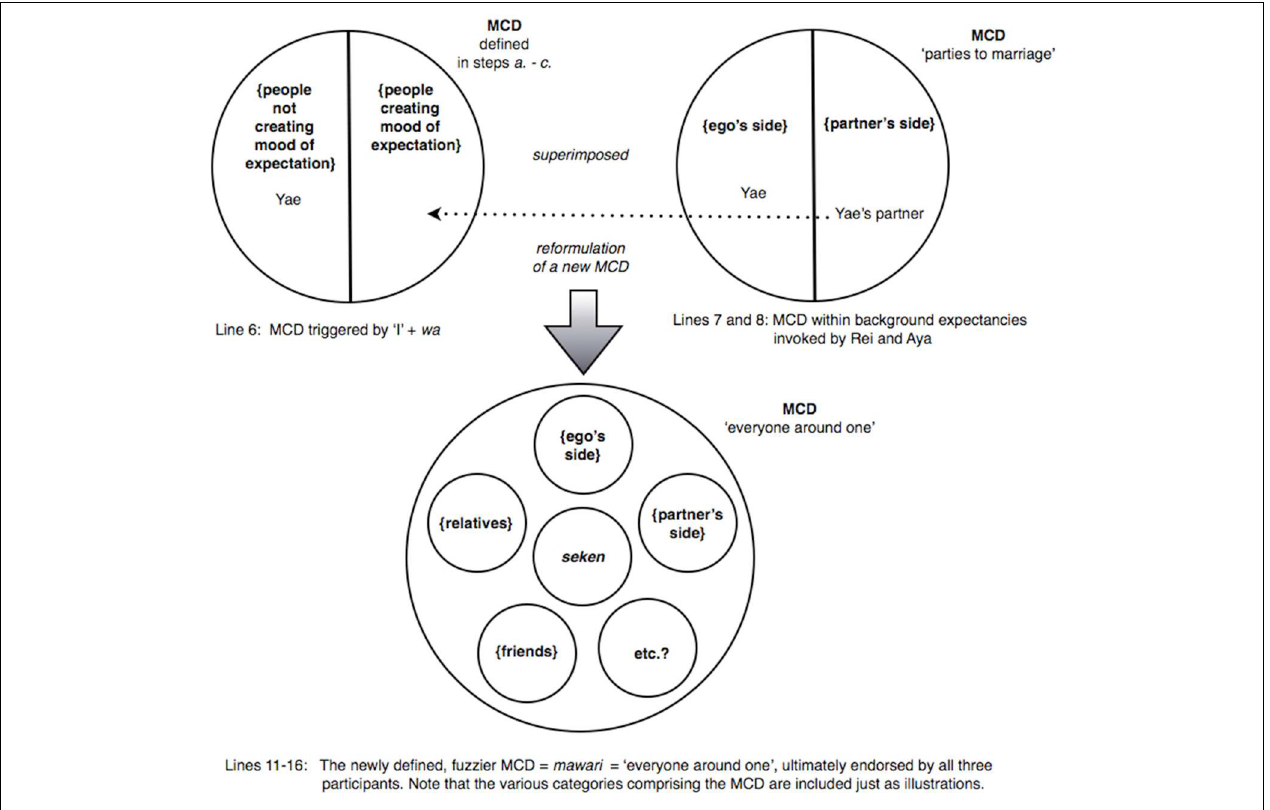
FIGURE 6 | Excerpt (9): Yae’s marking of “I” with wa triggers a MCD consisting of categories {people not creating mood of expectation} and {people creating mood of expectation}, with Yae belonging to the former (top left). Rei and Aya superimpose a MCD retrieved from their